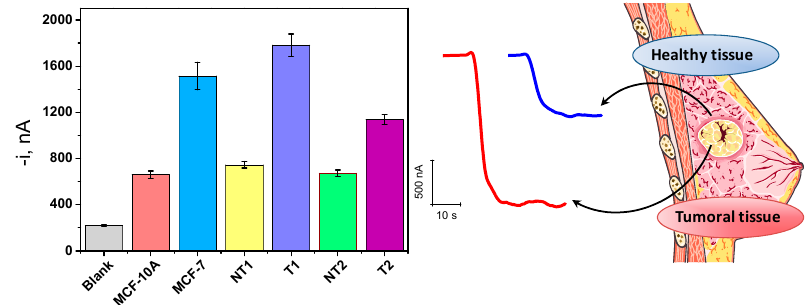
Figure 6. Amperometric responses measured with the developed biosensor for the determination of the endogenous content of miRNA-21 in 250 ng raw total RNA (RNA t ) extracted from cells and human breast tissues. Amperograms obtained for human tumor (T) and paired normal adjacent (NT) samples extracted from a breast cancer patient are also shown. Error bars estimated at triple the standard deviation of three replicates.